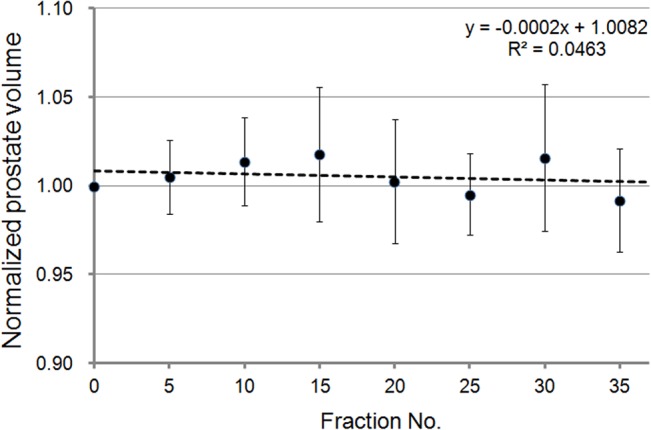
The relationship between radiation therapy fraction number and normalized prostate volume in 19 patients.There was no significant time trend.